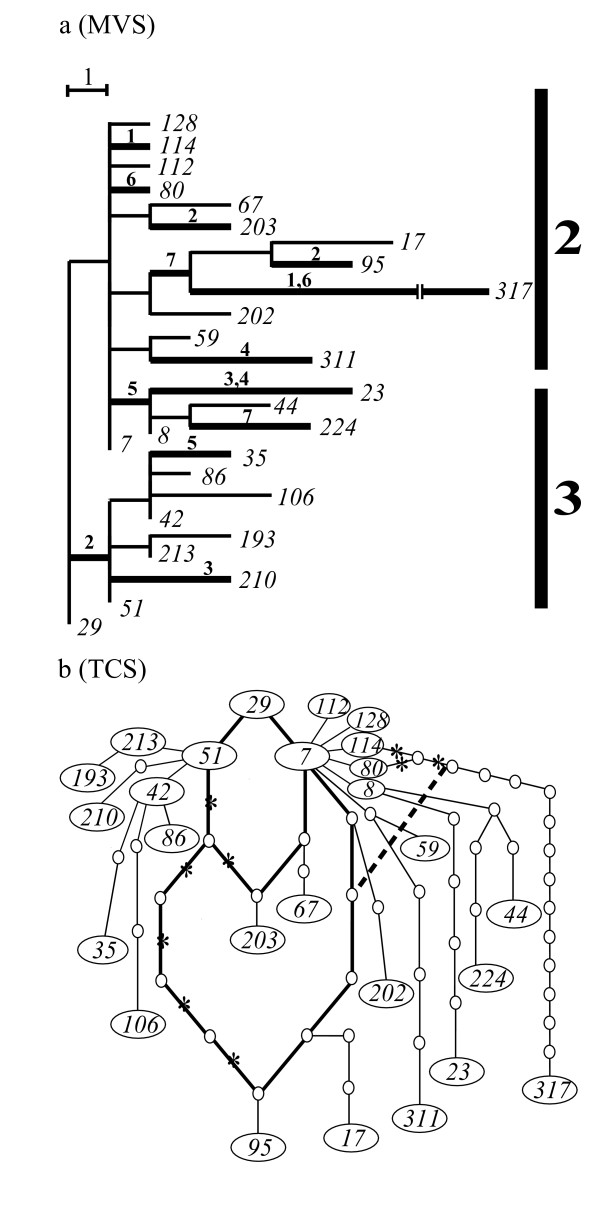
Core set tree compared to SP tree. We considered the 26 haplotypes of groups 2 and 3 in Fig. 4a. TCS had complicated loops in the tree (Fig. 6b). Removal of the branches marked with asterisks and changing the dotted line into a solid line gave our result (Fig. 6a), which was also uniquely reproduced by PAUP*. The occurrence of loops could be explained by parallel changes. The bold lines in Fig. 6a denote parallel changes of six pairs and one triplet.